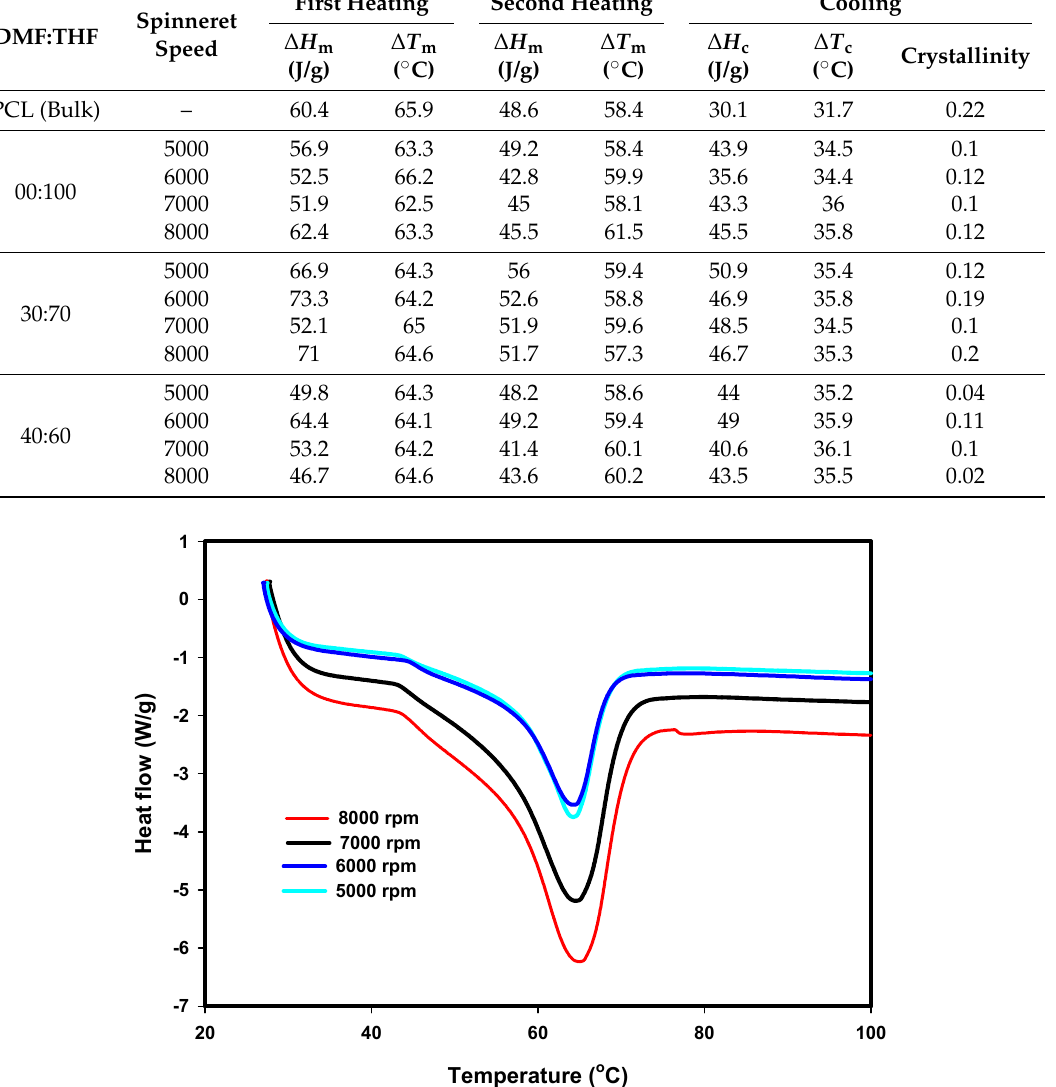
Figure 11. Melting endotherm of PCL fibers prepared by the FS of 12.5 wt% PCL solutions in DMF:THF (30:70 by volume) mixture at different rotational speeds.